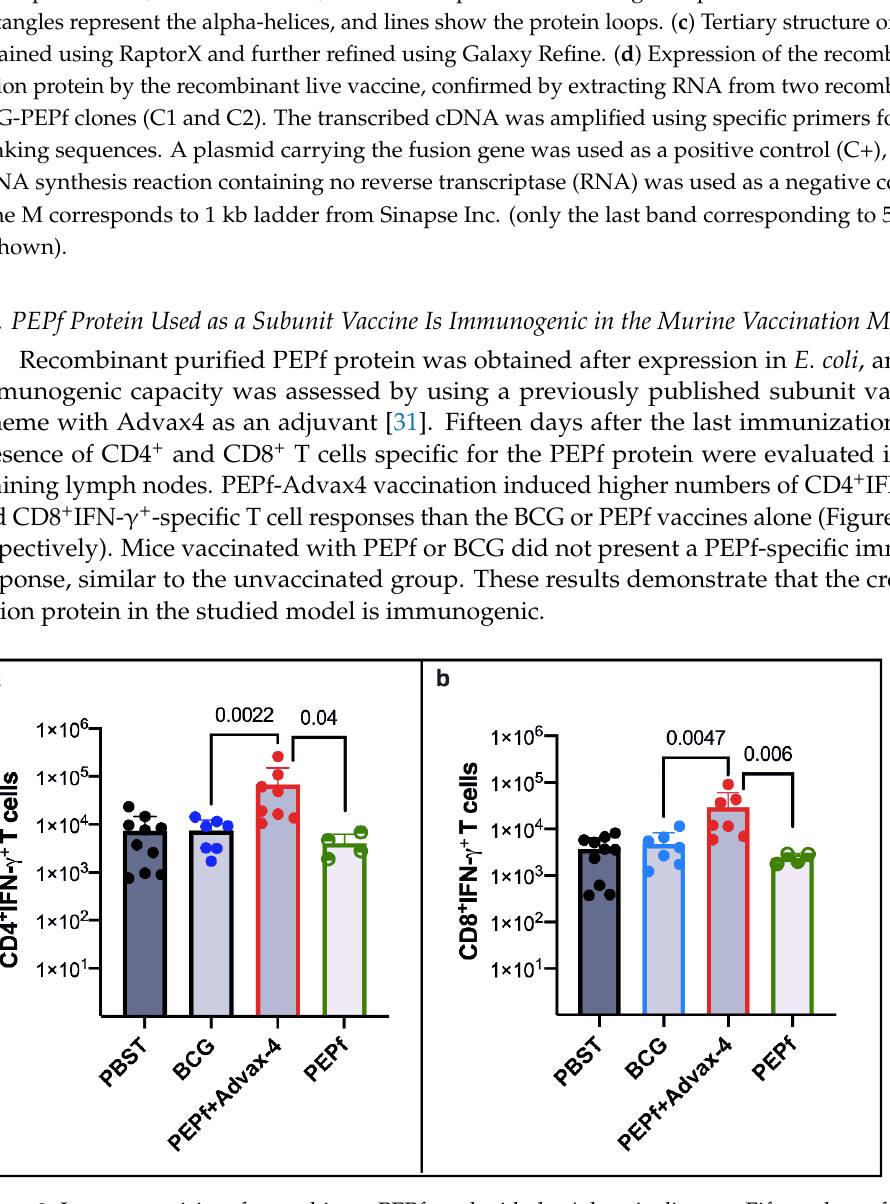
Figure 2. Immunogenicity of recombinant PEPf used with the Advax4 adjuvant. Fifteen days after the last immunization, lymph node cells from BALB/c PBST vaccinated (PBST, N = 8), BCG immunized (BCG, N = 8), with PEPf-Advax4 (PEPf + Advax4, N = 8), or PEPf alone (PEPf, protein control, N = 4) were analyzed. ( a ) CD4 + IFN- γ + T cells and ( b ) CD8 + IFN- γ + PEPf-specific T cells in the draining lymph nodes were determined and plotted on a logarithmic scale. The p -value is shown above the compared bars between significantly different groups. Data shown (circles) represent the cell numbers for each animal, and the horizontal bar shows the average (with SD) for each group of two independent experiments.